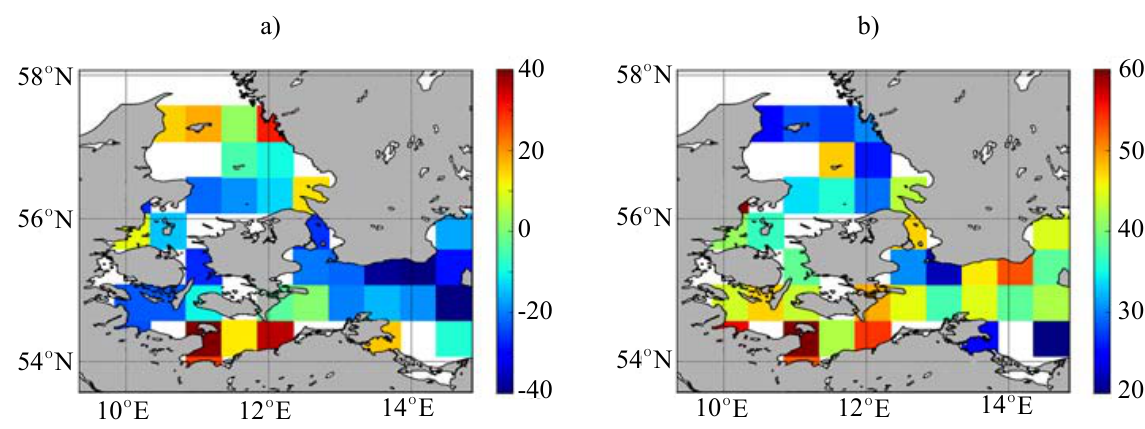
Fig. 5. Average spatial variation of the (a) oxygen bias and (b) average error during autumn for the years 2002–2006 (units in µmoll − 1 )